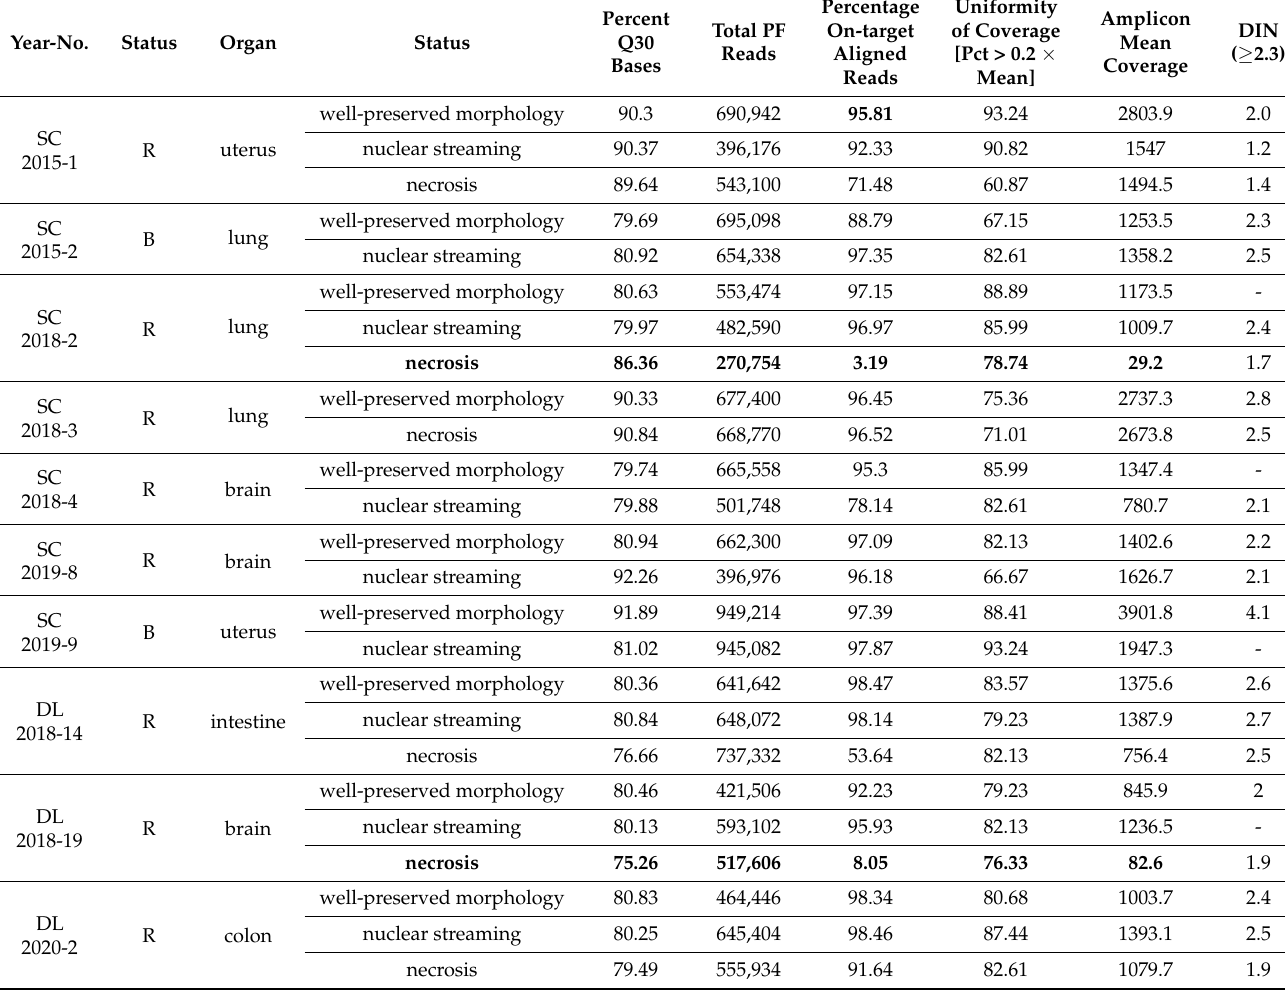
Table 2. Overall sequencing results for the 25 samples obtained from 10 cases.